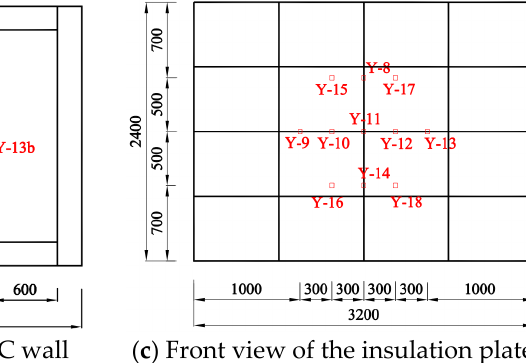
Figure 7. Arrangement of the gauges.